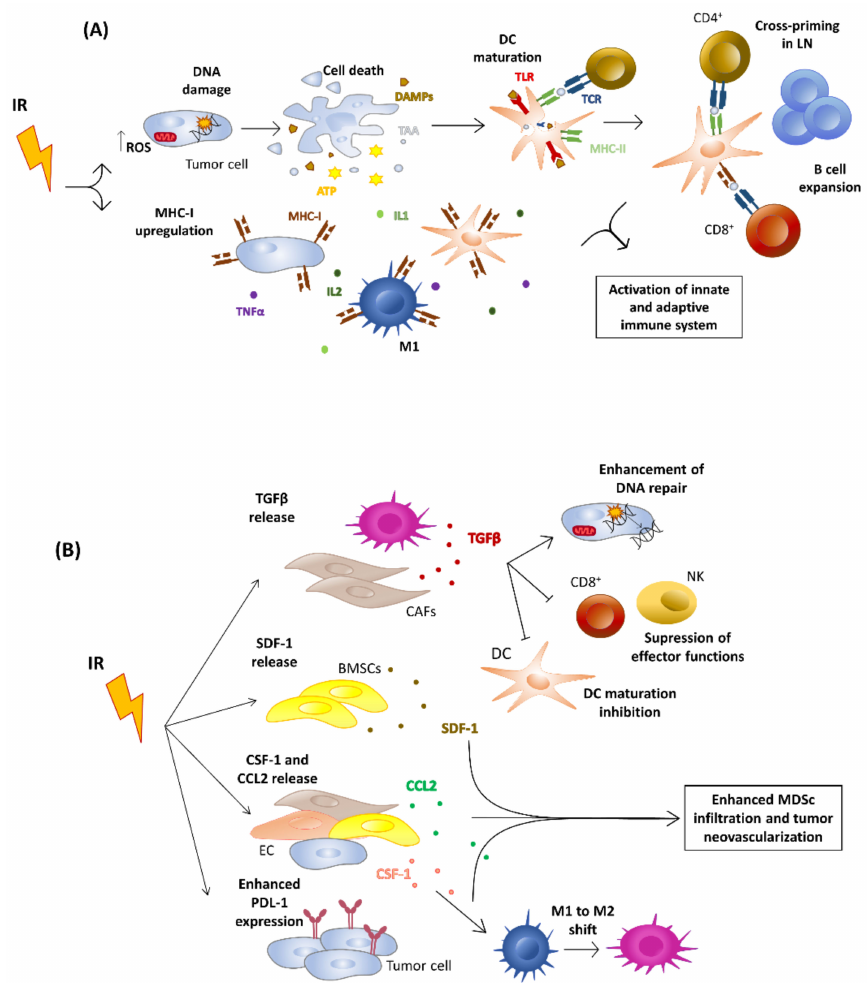
Figure 1. An overview of the Antitumorigenic and Pro-Tumorigenic effects of Radiotherapy. Basis of radiation-induced immunogenic cell death ( A ). Irradiation induces an increase in both ROS and MHC- I molecules in the tumor microenvironment, leading to DNA damage and more permissive antitumor activity by enhancing innate and adaptive cell activation. DNA damage induces apoptosis in tumor cells with the consequent release of ATP, DAMP and TAA which, through interaction with TLRs in DCs, cause their maturation. These mature DCs will migrate to the LN where they will cross-present Ag through MHC-I and II to CD8 and CD4 T cells, respectively, and trigger the clonal expansion of B lymphocytes. Barriers to radiation-induced immunogenic cell death ( B ). Irradiation can also induce the release of immunosuppressive molecules: TGF β release can inhibit DC maturation, suppress immune effector functions and enhance DNA repair; SDF-1, CSF-1 and CCL2 attract myeloid-derived suppressor cells and induce neovascularization; PDL-1 on the tumor surface can interact with its PD-1 counterpart on T cells, leading to their inactivation. Point arrows mean activation while blunt arrows mean inhibition. ROS reactive oxygen species; DC, dendritic cell; DAMPs, damage-associated molecular patterns; TAA, tumor associated antigens; TLR, toll-like receptor; TCR, T cell receptor; MHC, major histocompatibility complex; TNF α , tumor necrosis factor; IL, interleukin; LN, lymph node; BMSCs, born marrow stromal cells; CAFs, cancer associated fibroblast; TGF β , transforming growth factor receptor; NK, natural killers; SDF-1 stromal cell-derived factor 1; CCL2, C-C motif chemokine ligand 2; CSF-1, colony-stimulating factor 1; PDL-1, programmed death ligand 1; MDSc, myeloid derived suppressor